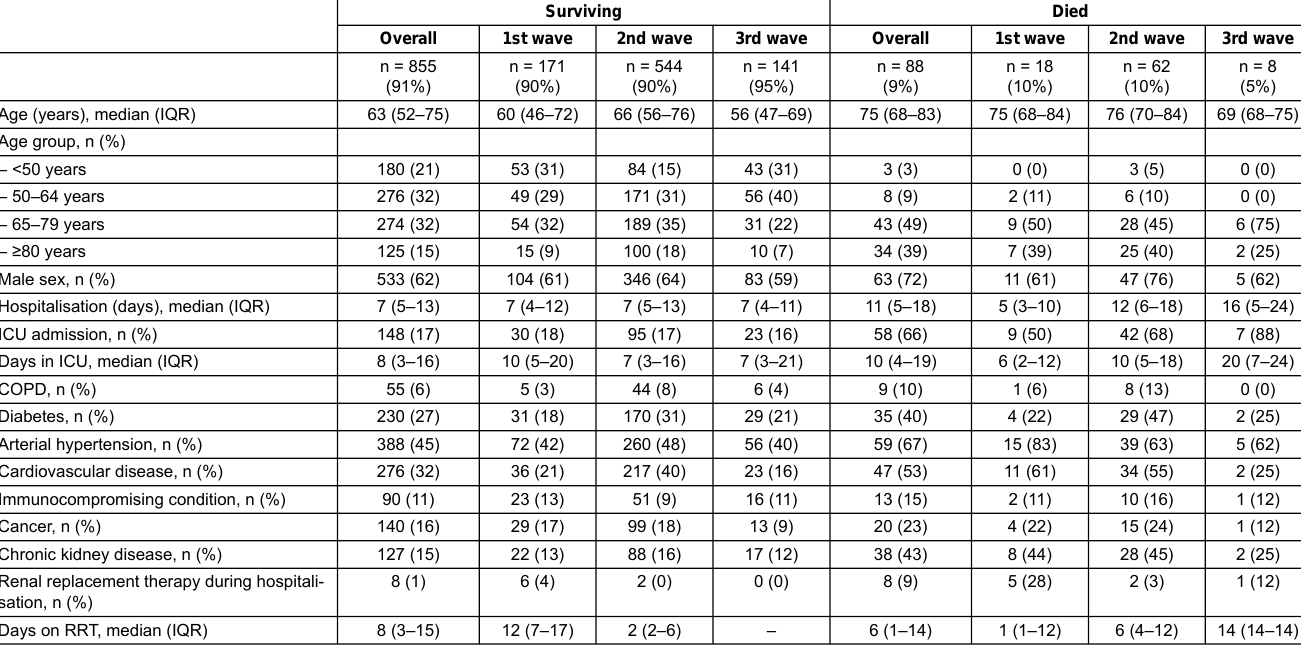
Table 2: Baseline characteristics of all patients and stratified by each wave, and survivors and patients who died.